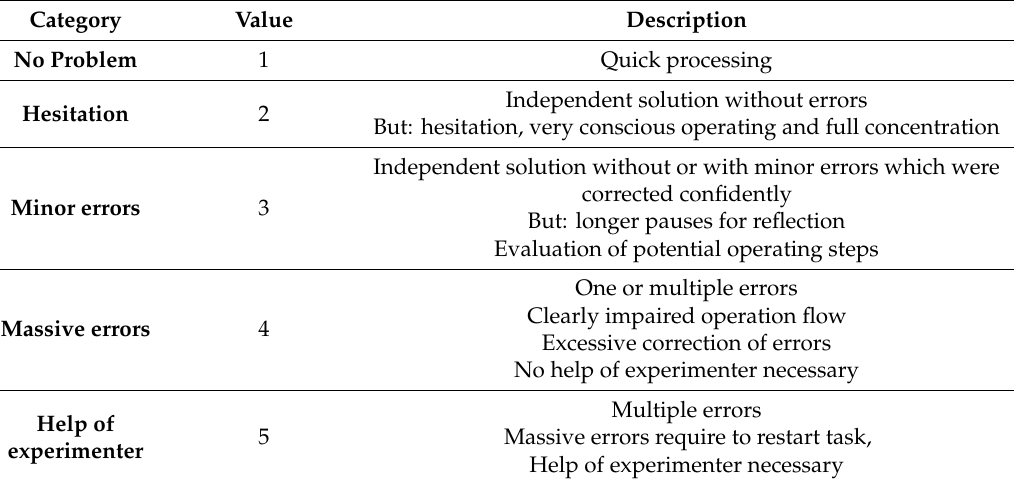
Table 6. Experimenter rating with label and